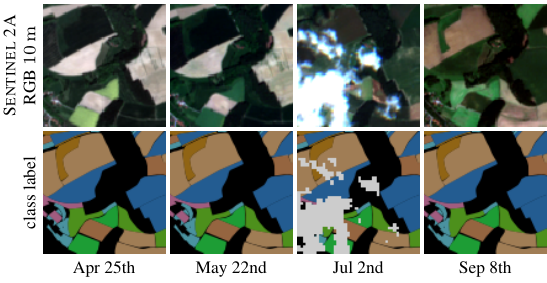
Figure 1. Sequence of observations during the growth season of the year 2016. S ENTINEL 2A RGB bands (top row) illustrate the systematic and characteristic change of crops over the season. Class labels (bottom row) show the ground truth labels, as